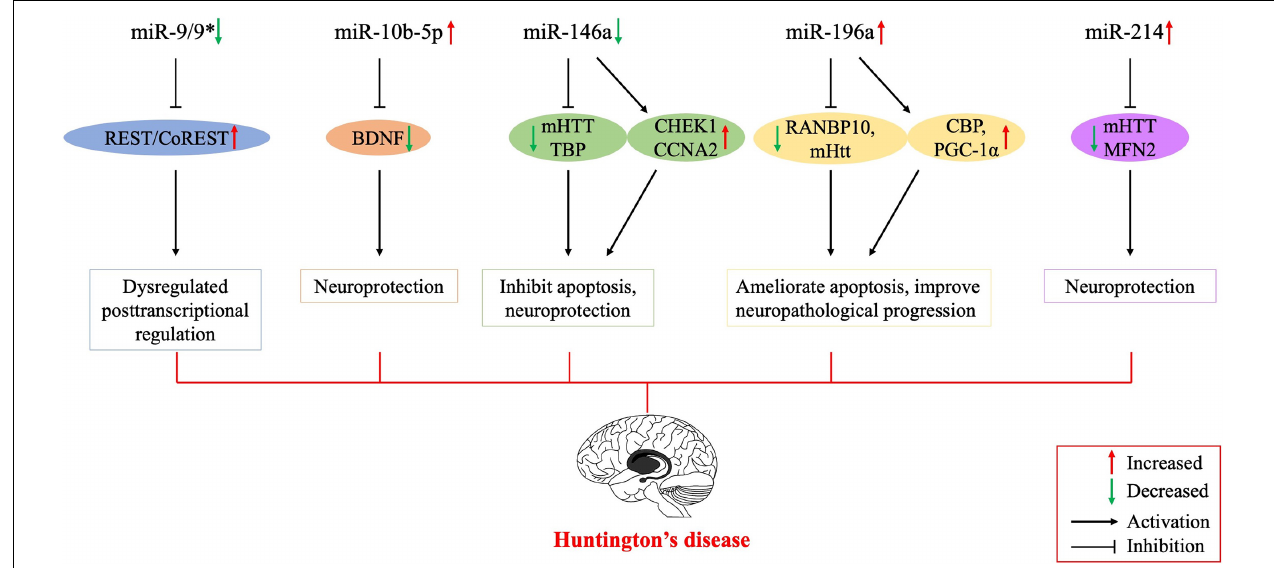
FIGURE 1 | Possible mechanisms of the involvement of dysregulated microRNAs in the pathogenesis of Huntington’s disease. Several studies have been conducted on Huntington’s disease to regulate the expression of miRNAs for therapeutic purposes, and their results encourage further molecular research on all major neurodegenerative diseases, including Huntington’s disease. BNDF, brain-derived neurotrophic factor; CBP, cyclic AMP-response element-binding (CREB) protein; CCNA2, cyclin A2; CHEK1, checkpoint kinase 1; mHTT, mutant huntingtin; PGC-1 α , peroxisome proliferator-activated receptor- γ coactivator-1 α ; MFN2, mitofusin2; REST, repressor element 1-silencing transcription factor; RANBP10, RAN binding protein 10; TBP, tata binding protein. *indicates the passenger strand of miR-9.